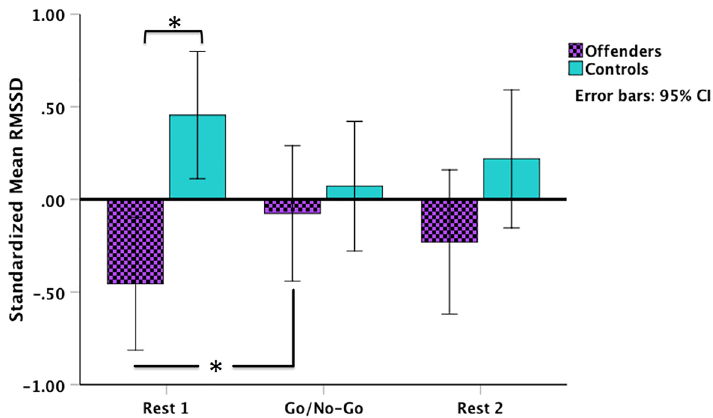
Figure 1. Parasympathetic activity (standardized RMSSD values) in the offender and control groups at baseline (Rest 1), during the emotional Go/No-Go task, and in recovery (Rest 2). Offenders’ RMSSD mean was significantly lower than the controls at baseline, but increased significantly during the task and to a similar level as the controls. * p FDR < 0.05.